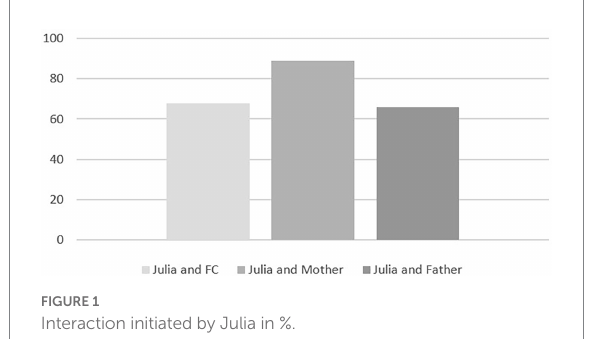
FIGURE 1 Interaction initiated by Julia in